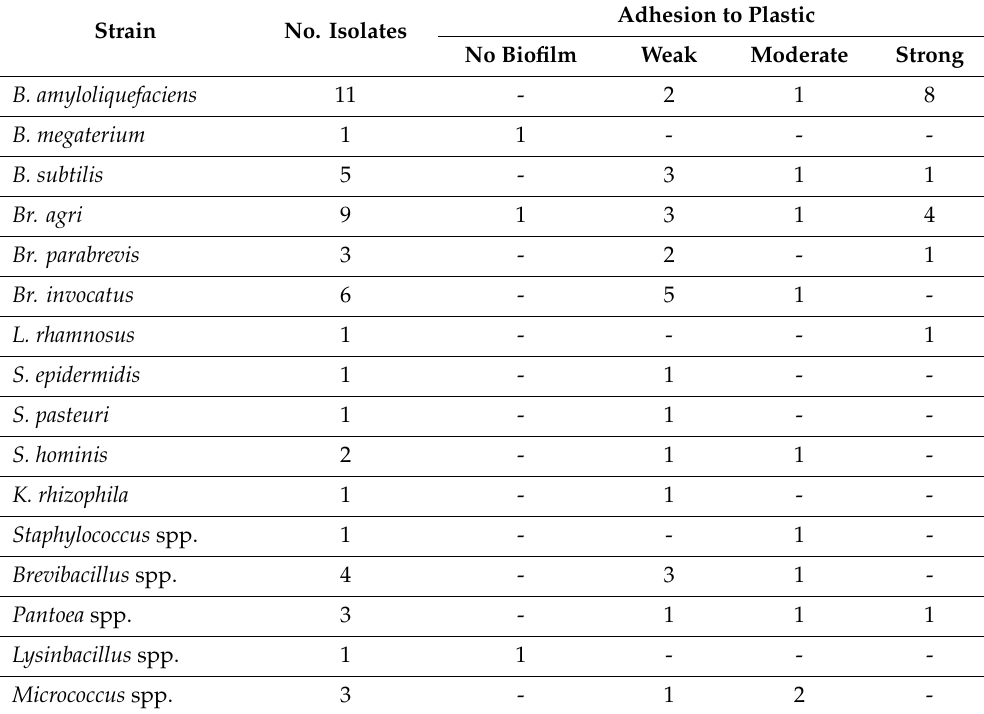
Table 3. Biofilm formation of